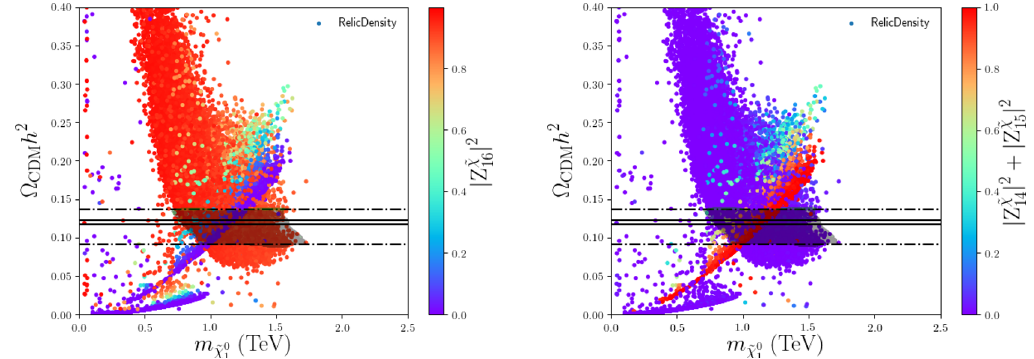
Figure 6 . Relic density predictions for singlino-like (left) and higgsino-like (right) DM as a function of the mass of the neutralino LSP. The colour bars show the composition of the LSP. The meaning of the horizontal lines is explained in the